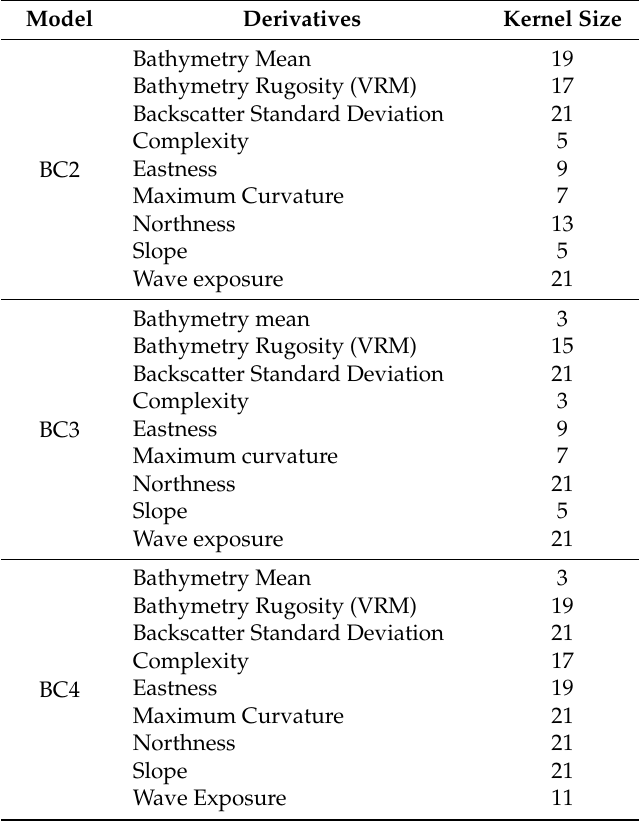
Table 3. Model predictors and spatial scale retained for each